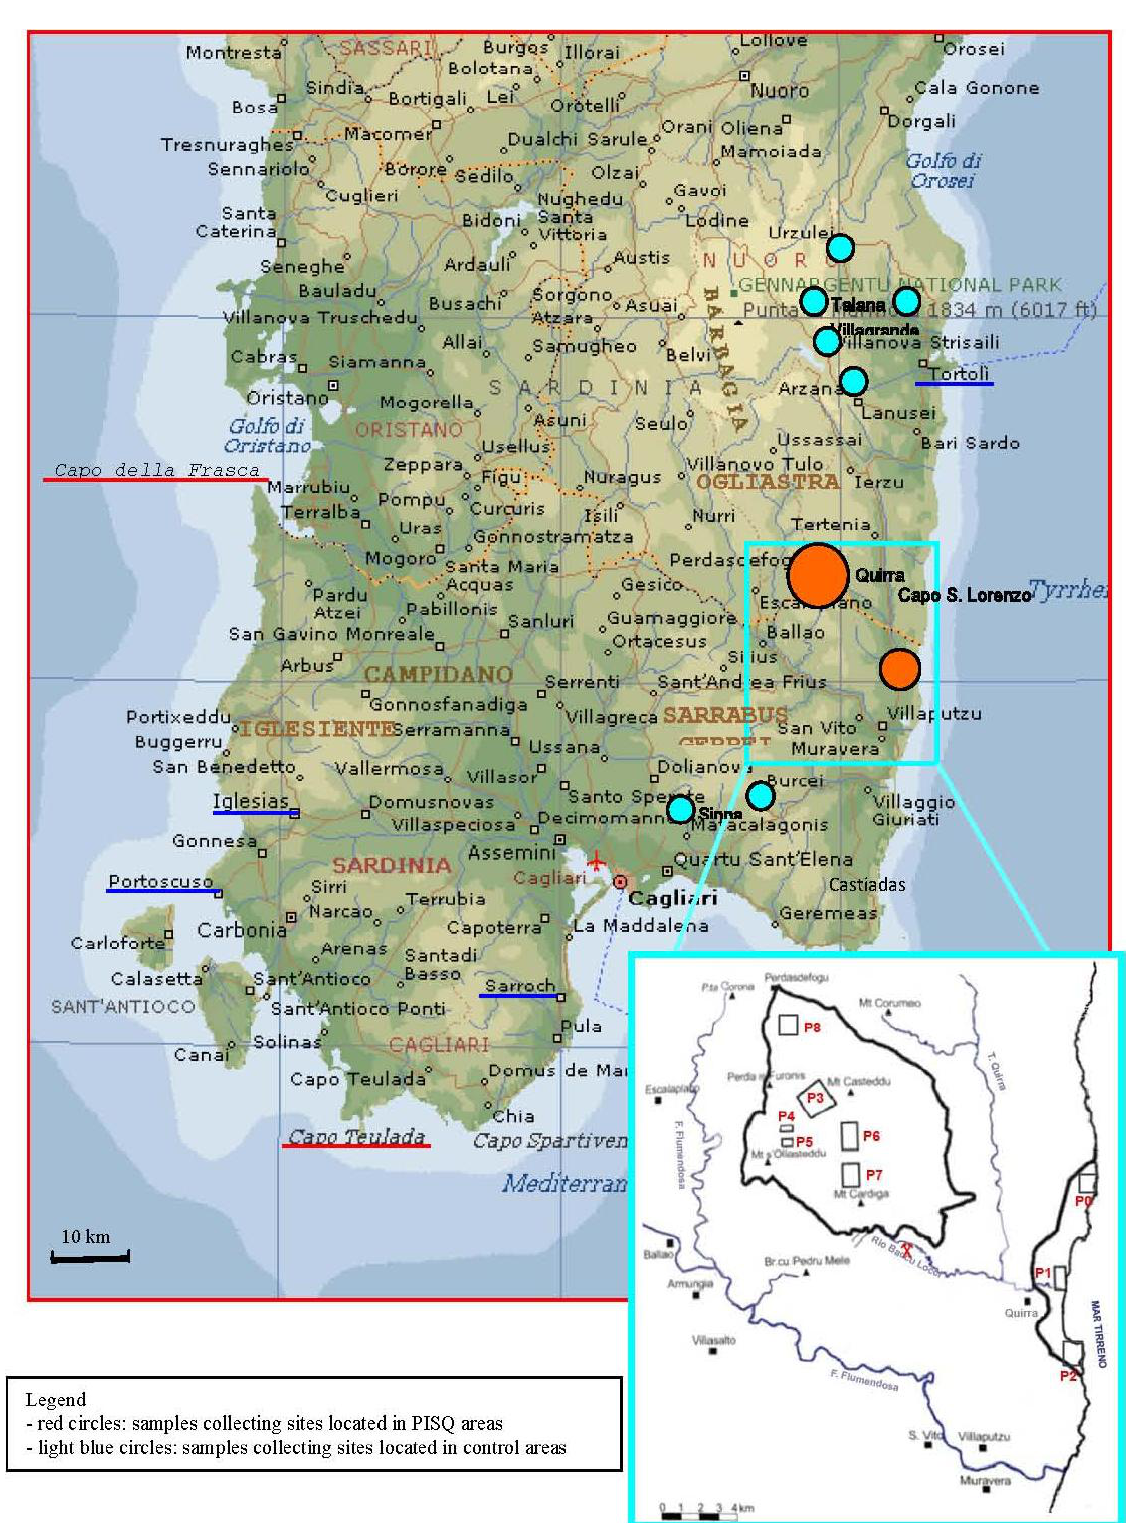
Figure 1. Geographic distribution of risk areas in Sardinia